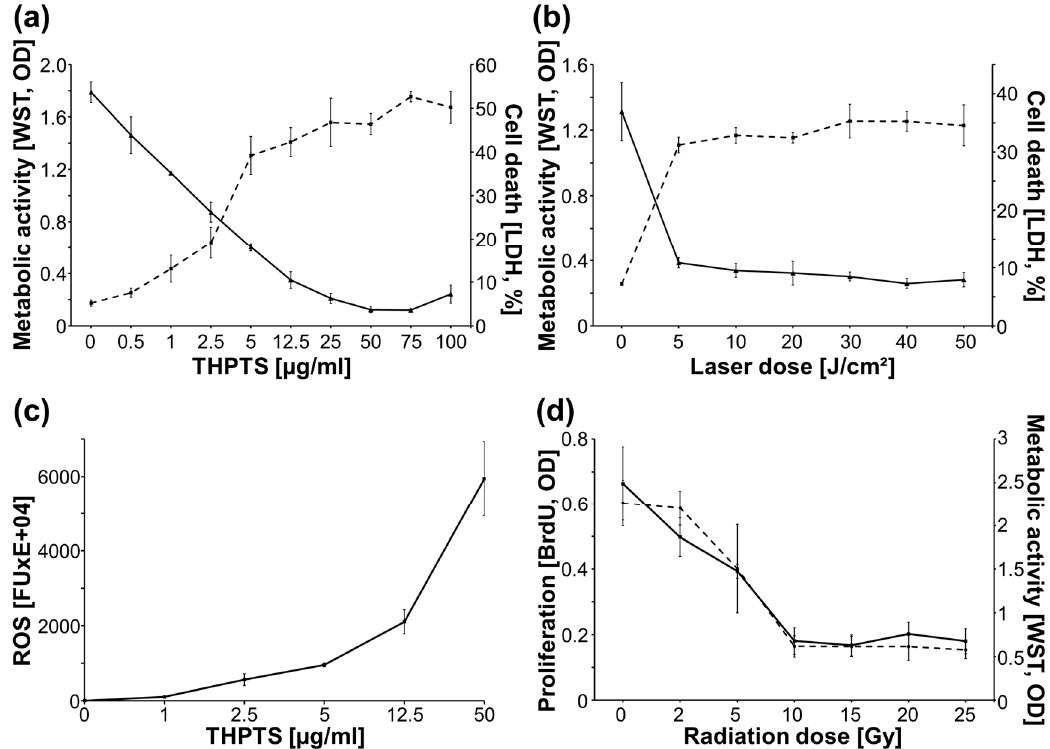
Figure 1. Effect of THPTS-PDT and IR on GL261 cells. THPTS ( a ) and laser ( b ) dose-dependent decrease of metabolic activity, increase of cell death (LDH, dashed line); and ( c ) increased release of reactive oxygen species (ROS) after THPTS-PDT; ( d ) inhibition of proliferation and metabolic activity (WST-1, dashed line) by irradiation; mean ± SEM of one experiment in triplicates.